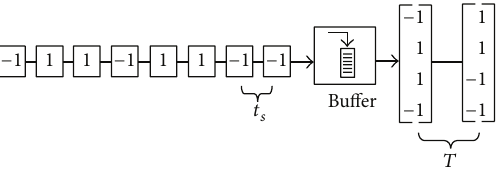
Figure 3: Buffer redistributes the incoming samples into 2 sets of